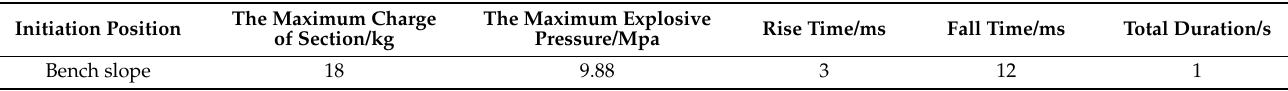
Table 5. Blasting parameter